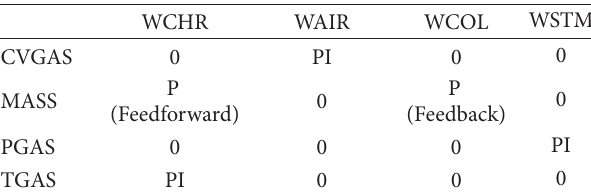
Table 1: Controller structure.